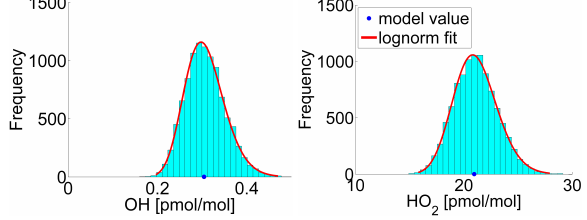
Fig. 8. Distribution of the OH- and HO 2 -mixing ratio derived from Monte-Carlo simulation of the data set observed in the upper tropo- sphere over Europe, see Sect. 4 for details. The model value indi- cates the simulated mixing ratio resulting from the model run, when no Monte-Carlo variation was